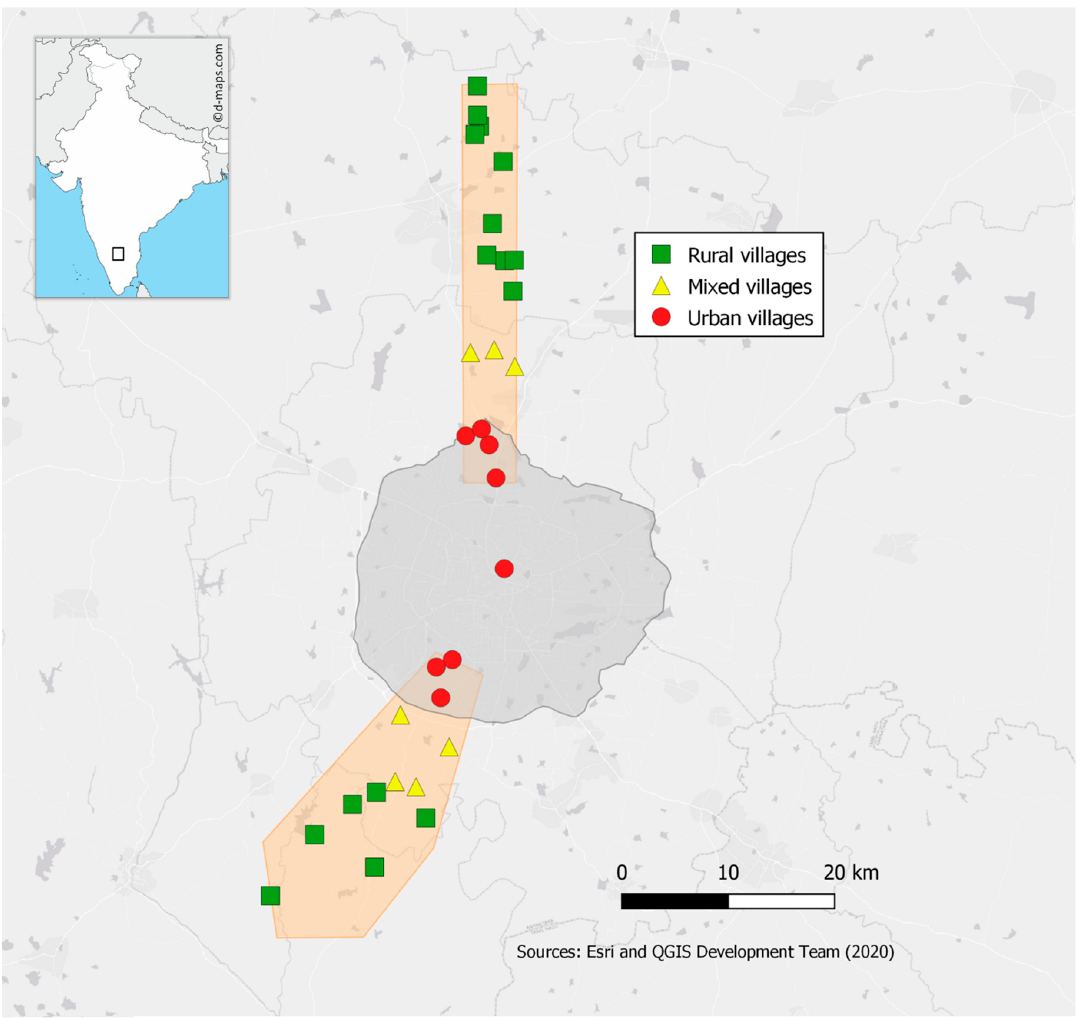
Figure 2. Map of Bangalore depicting the 31 sampled settlements. The dark grey area represents the urban city zone. The orange contours indicate the northern and southern transects.